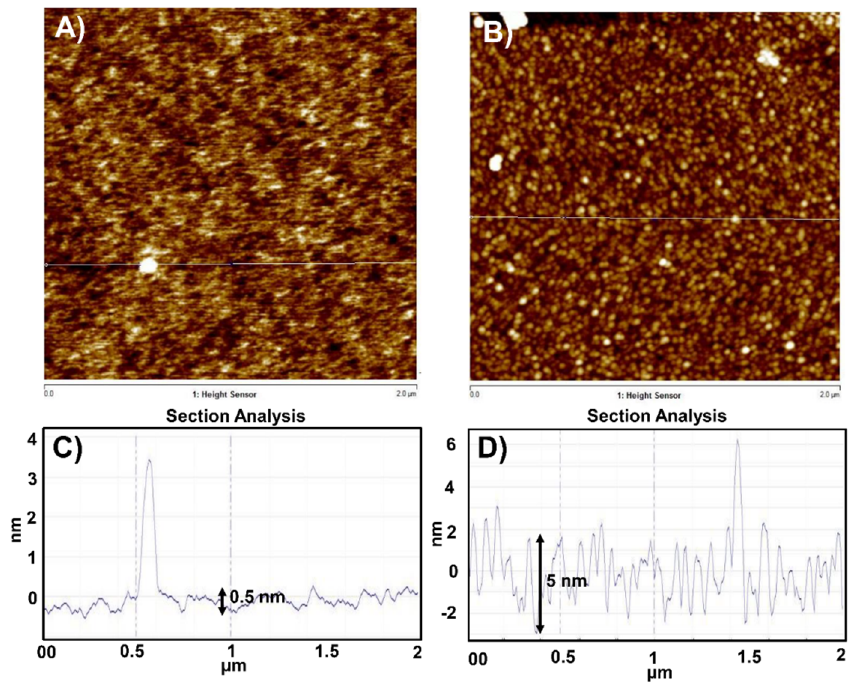
Figure 4. Surface morphology of the SiO 2 substrate before and after assembly of the Al 2 O 3 nanoparticle monolayer. AFM images of ( A ) the bare SiO 2 substrate and ( B ) the Al 2 O 3 nanoparticle monolayer. Height cross-sectional profiles (surface roughness) of ( C ) the bare SiO 2 substrate and ( D ) the Al 2 O 3 nanoparticle monolayer.